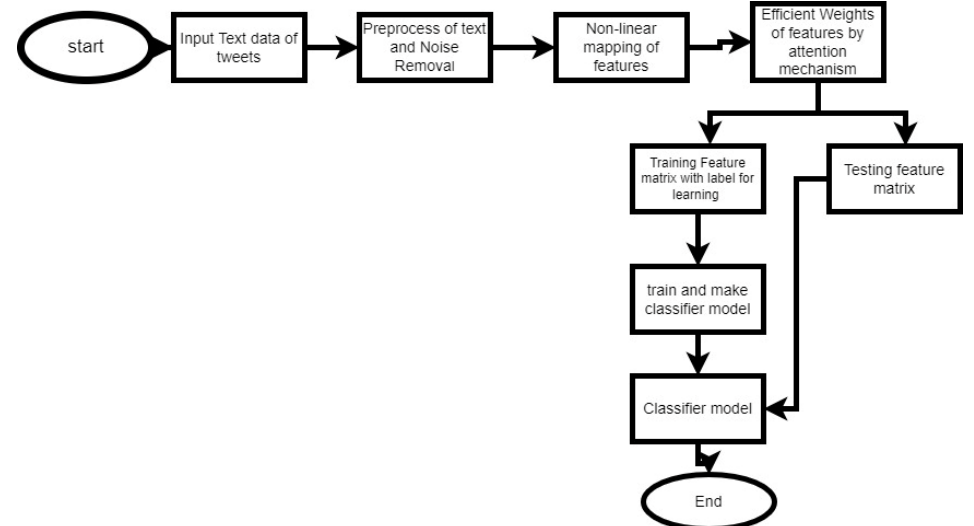
Figure 1. Tweet classification architecture.